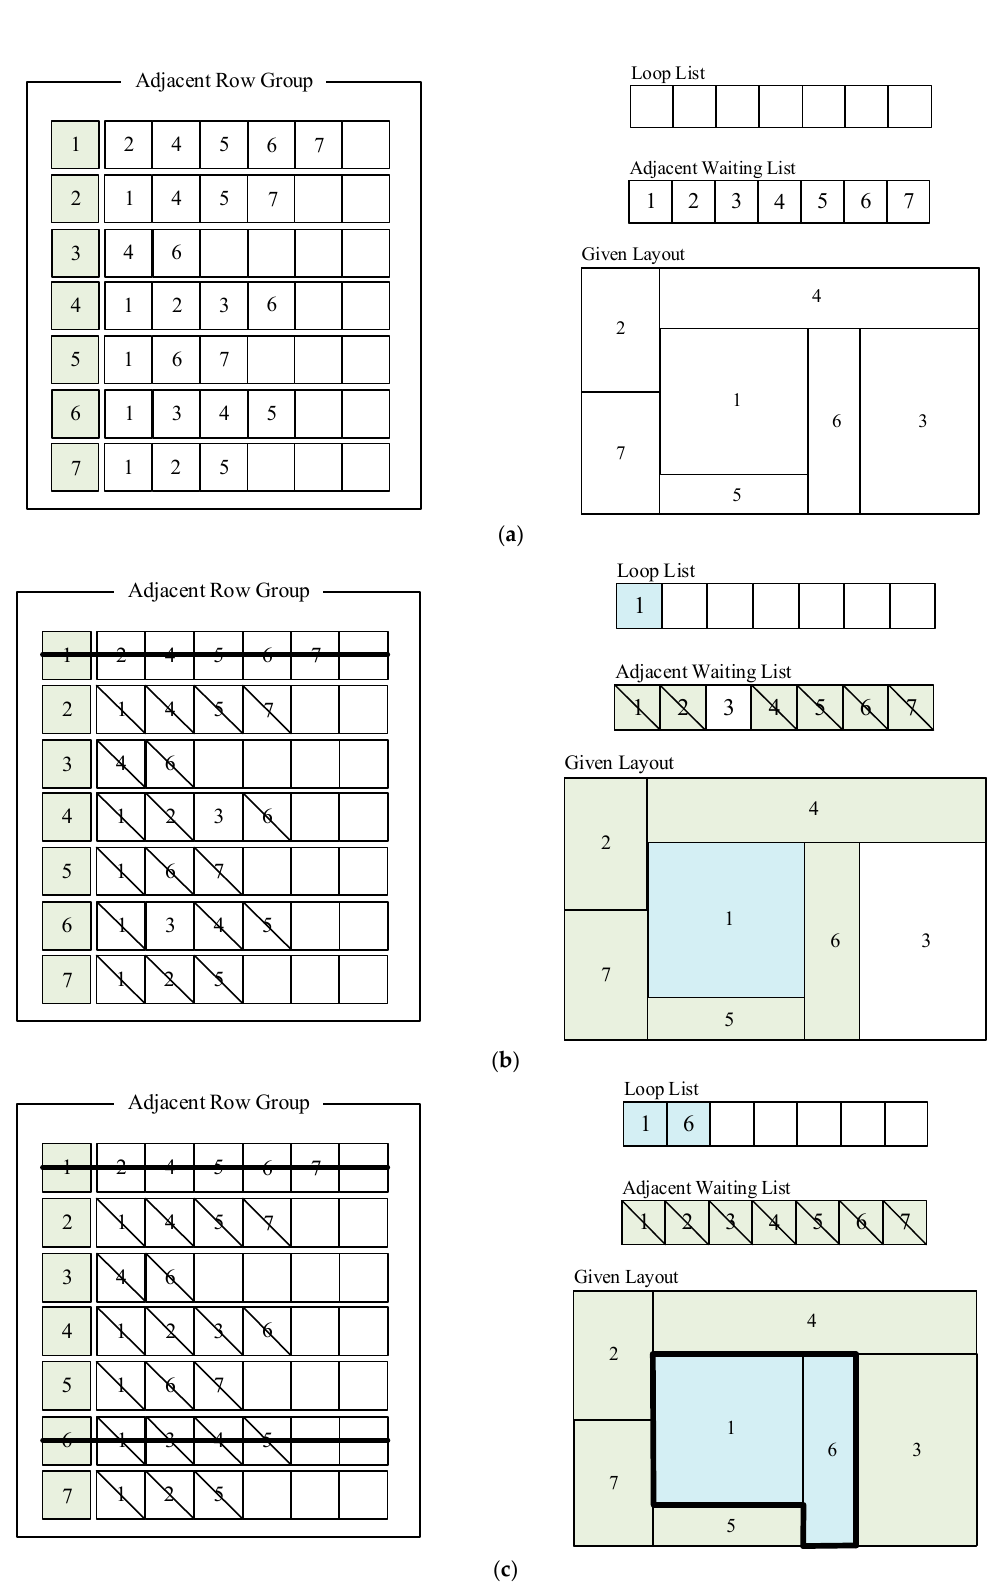
Figure 11. Single loop construction steps. ( a ) Step 1; ( b ) Steps 2–4 with Iteration 1; ( c ) Steps 2–4 with Iteration 2.